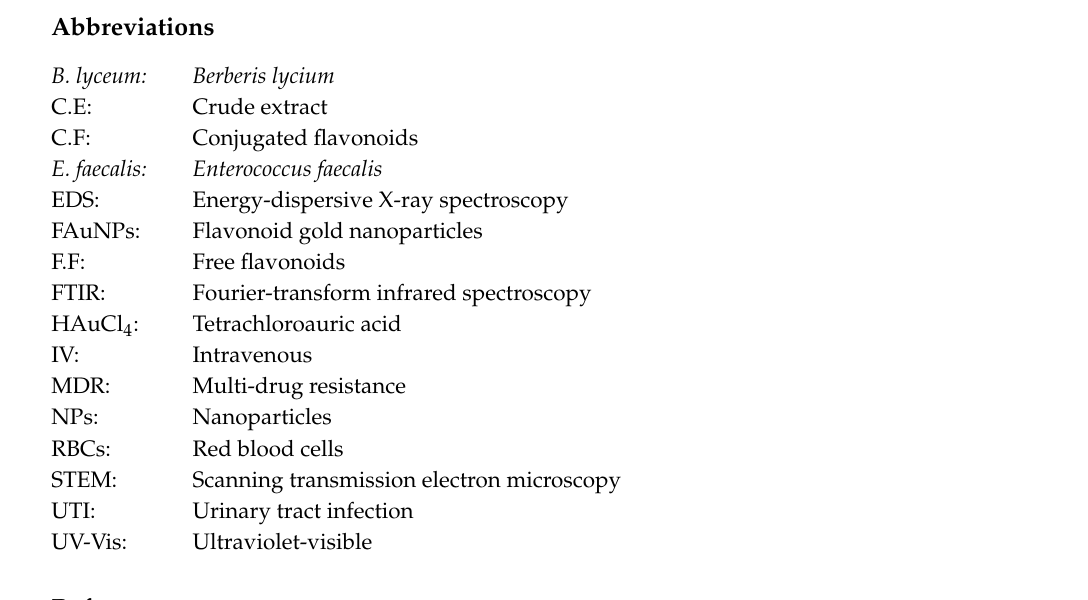
Figure S1: Extraction procedure for free and conjugated